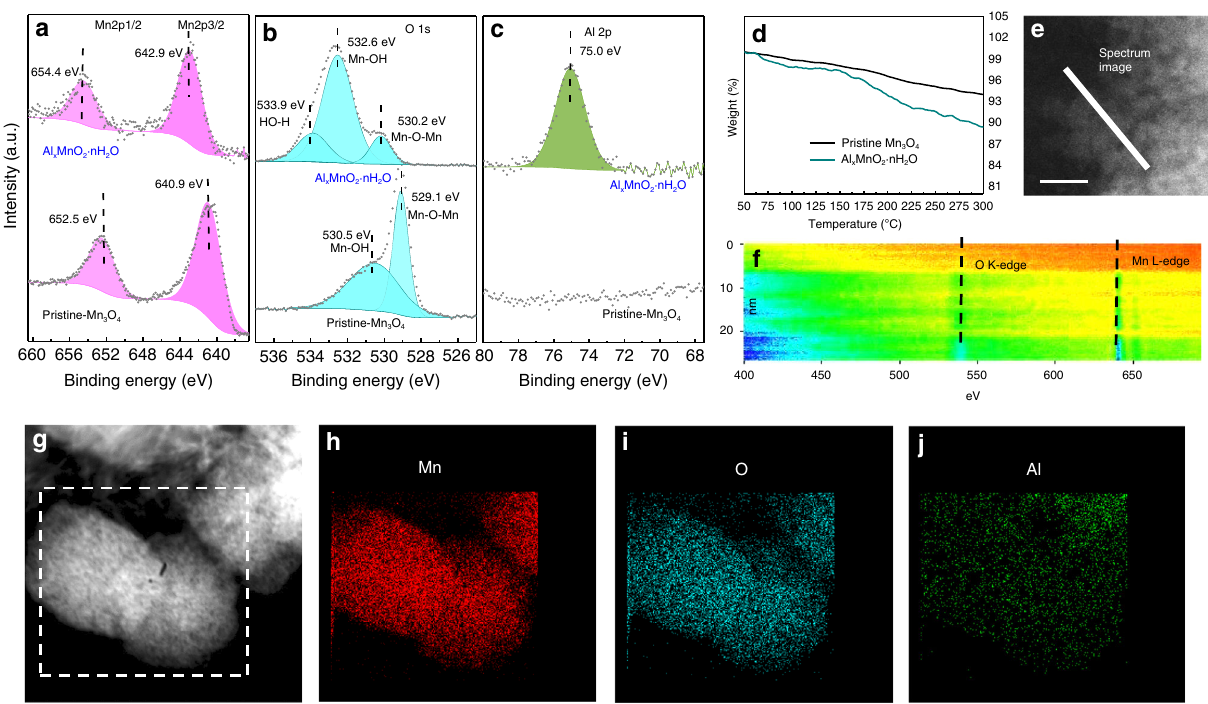
Fig. 1 The evidences of electrochemical transformation from spinel Mn 3 O 4 into layered A x MnO 2 · n H 2 O. a Mn2p, b O1s XPS, and c Al2p spectra of Mn 3 O 4 and the Al x MnO 2 · n H 2 O. d DTG curve for Mn 3 O 4 and Al x MnO 2 · n H 2 O. e HAADF image for EELS line scanning pathway as indicated by the white line. f Mn L-edge and O K-edge EELS spectrum along the scanning pathway in e . g Low-magni fi cation STEM image and h – j element mappings of a Al x MnO 2 · n H 2 O: h Mn, i O, j Al. Scale bar: 10 nm for